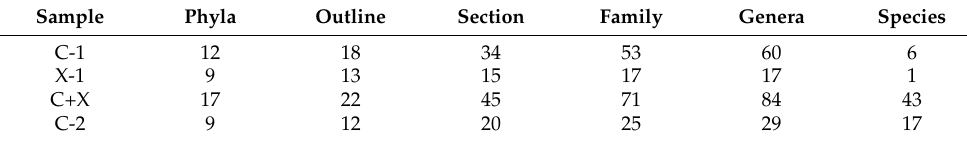
Table 3. The number of species under different classification levels in each sample.